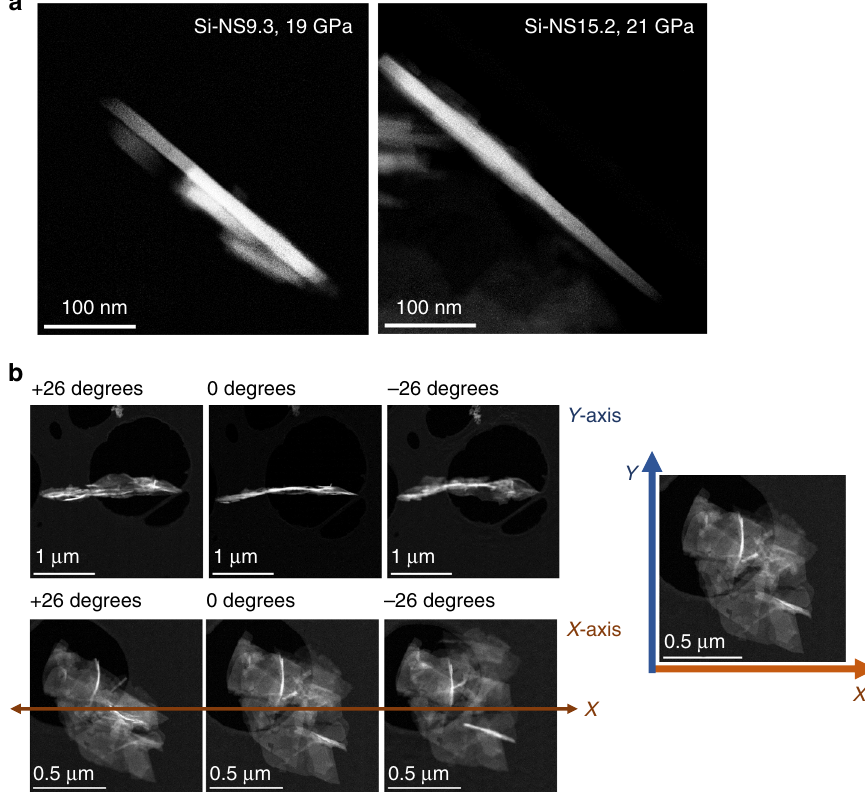
Fig. 5 HAADF-STEM images of isolated 1D Si-nanowires. a Isolated Si-NS9.3_19 GPa and Si-NS15.2_21 GPa. b The rotational HAADF-STEM images of the 1D Si-nanowires